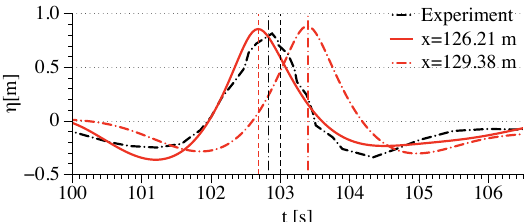
Figure 8. The comparison of the time series at the designated focusing location at x = 126.21 m and at the real focusing location at x = 129.38 m as detected in the numerical simulation. The black dash-dot curve is the time series measured in the experiment at x = 126.21 m and the vertical black dash-dot line indicates the measured focusing time at t = 102.825 s. The red solid curve is the time series at x = 126.21 m in the numerical wave tank (NWT), and the vertical red dashed line indicates the corresponding numerical focusing time t = 102.7 s. The red dash-dot curve is time series at the real focusing location x = 129.38 m in the NWT and the vertical red dash-dot line indicates the real focusing time t = 103.4 s. The vertical black dashed line is the designated focusing time at t = 103